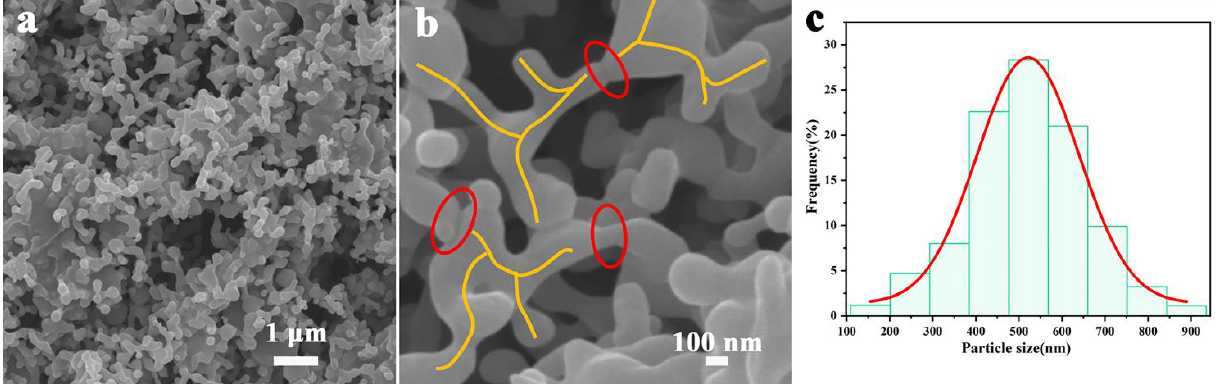
Figure 1. ( a , b ) SEM images and ( c ) particle size distribution of B-Al 2 O 3 .